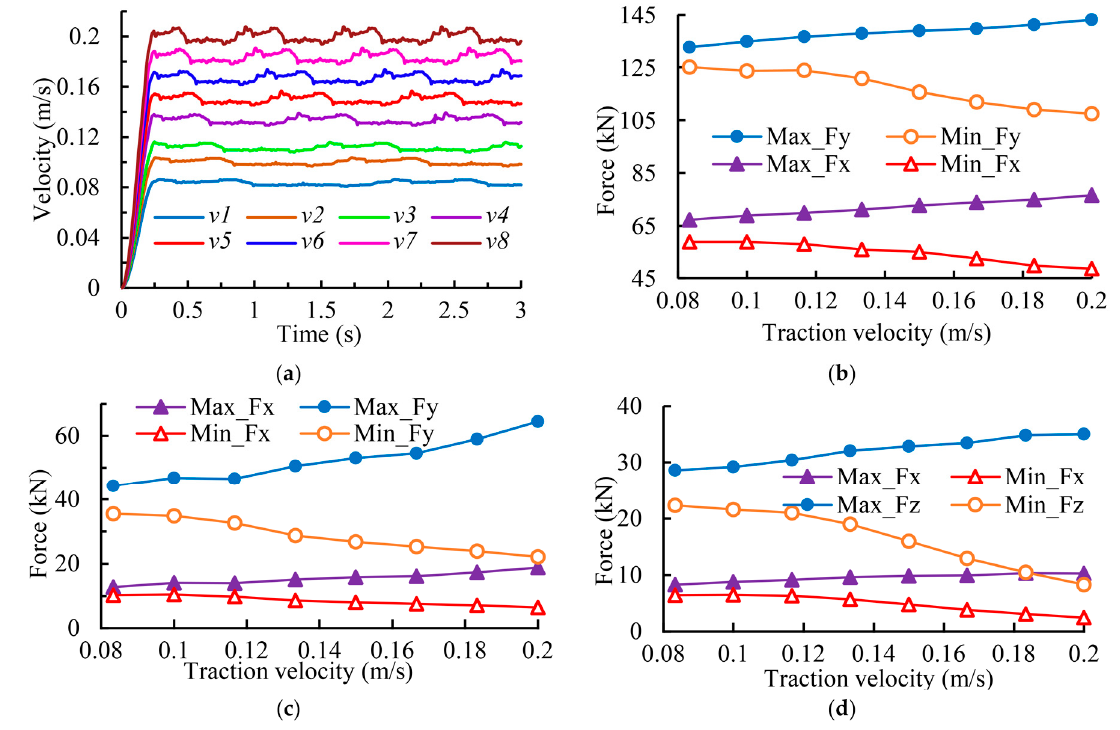
Figure 4. Dynamic properties of traction unit at different traction velocities: ( a ) Actual walking velocity of the shearer; ( b ) Contact force of the walking wheel; ( c ) Contact force of the support slipper; and ( d ) Contact force of the guide slipper.